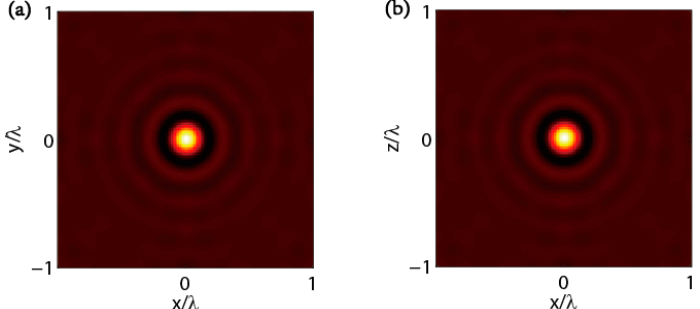
Figure 7. Point-spread function (PSF) image of TDM in complete configuration ( a ) Transverse cut of the PSF at z = 0. ( b ) Longitudinal cut of the PSF at y = 0.